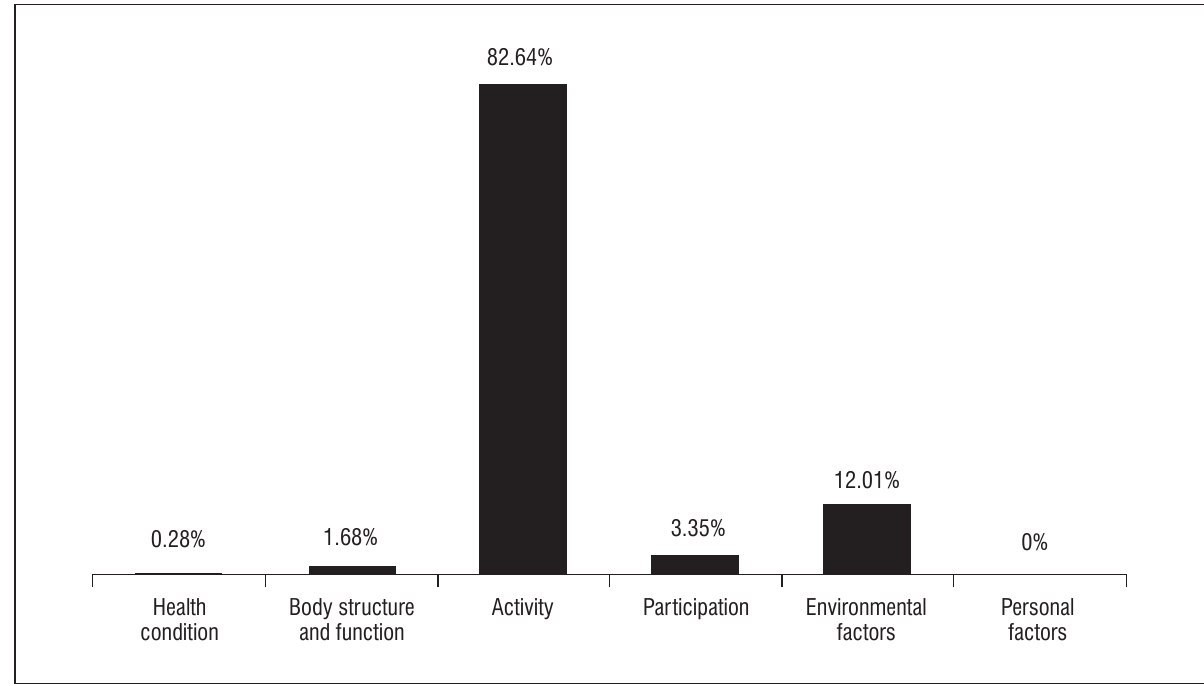
Figure 2 - ICF encoding total frequency in the included